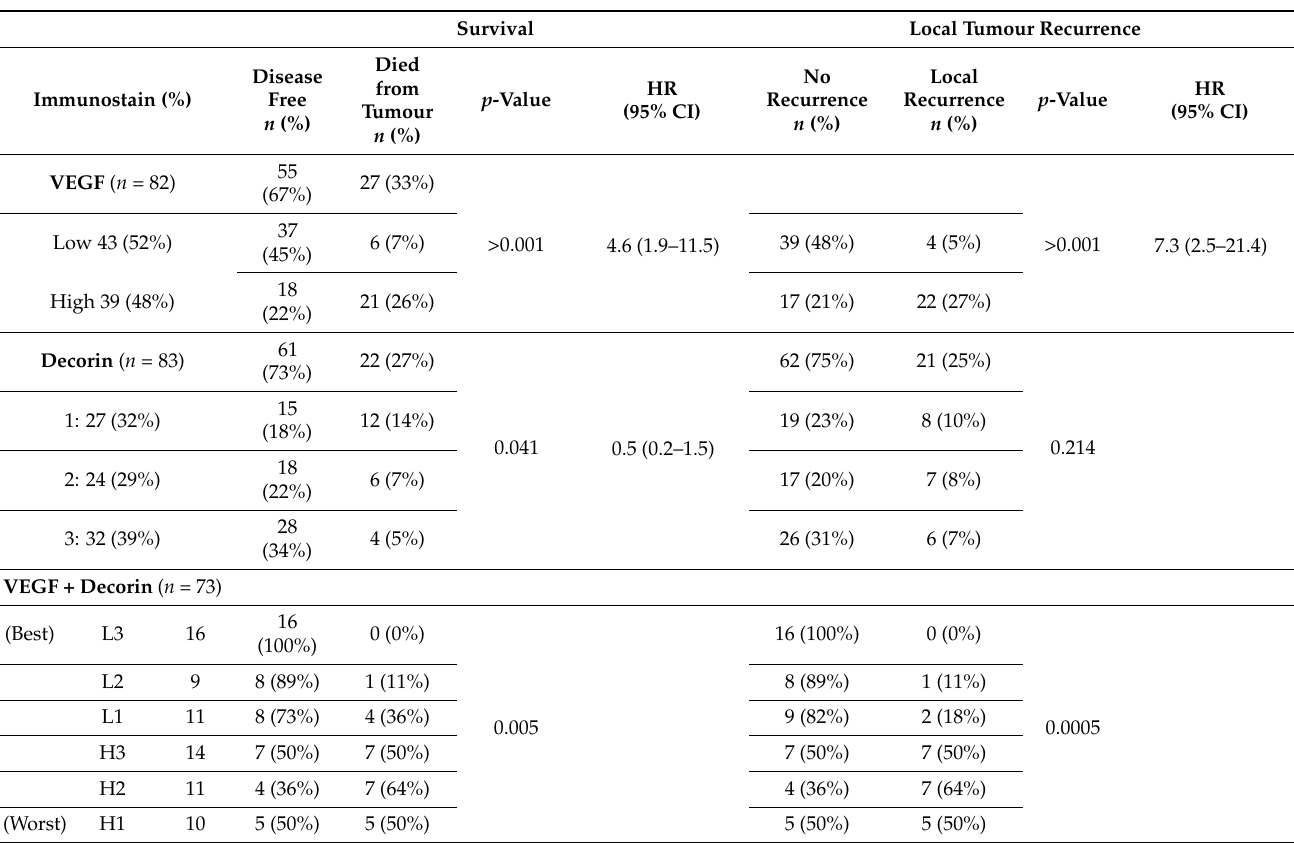
Table 4. Univariate cox-regression analysis for survival and local recurrence for patients based on VEGF, decorin and combined immunostaining